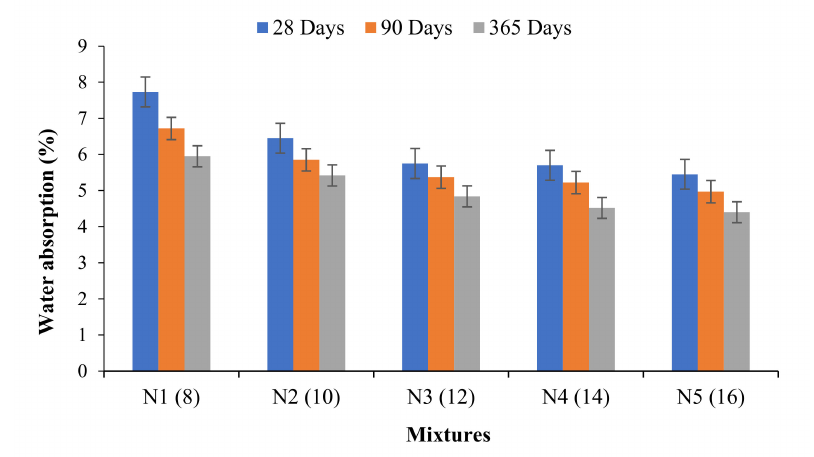
Figure 8. Water absorption of